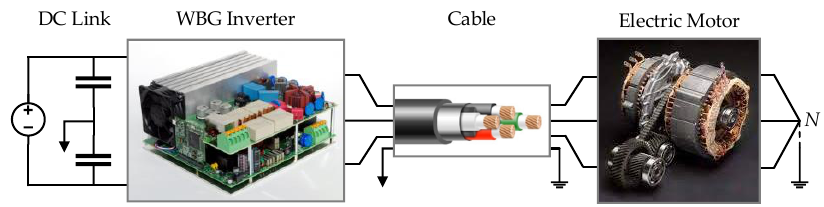
Figure 1. A WBG drive system consisted of the inverter, cable, and electric